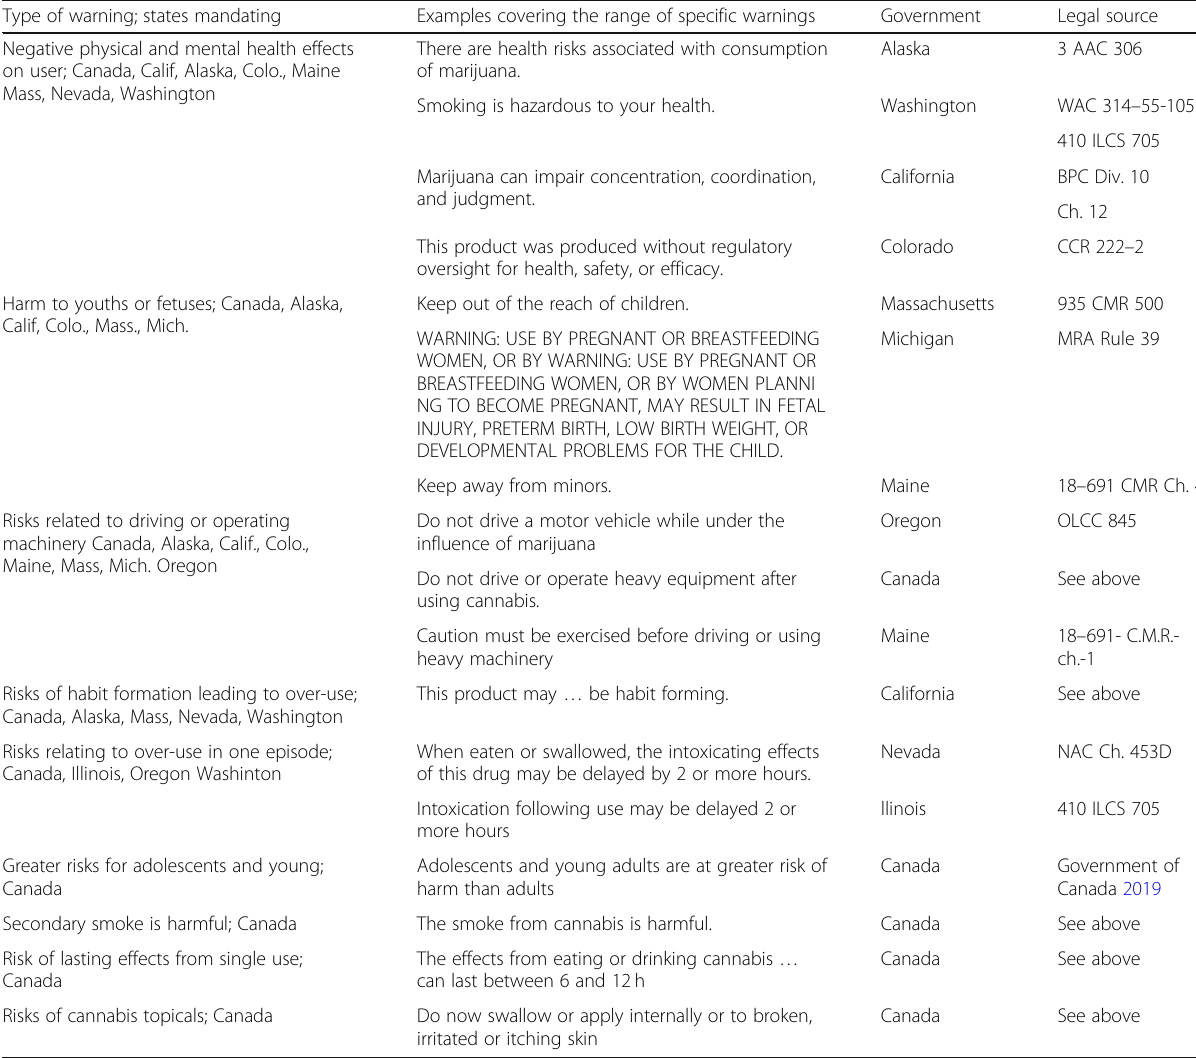
Table 1 Government-mandated warnings on recreational cannabis packaging Type of warning; states